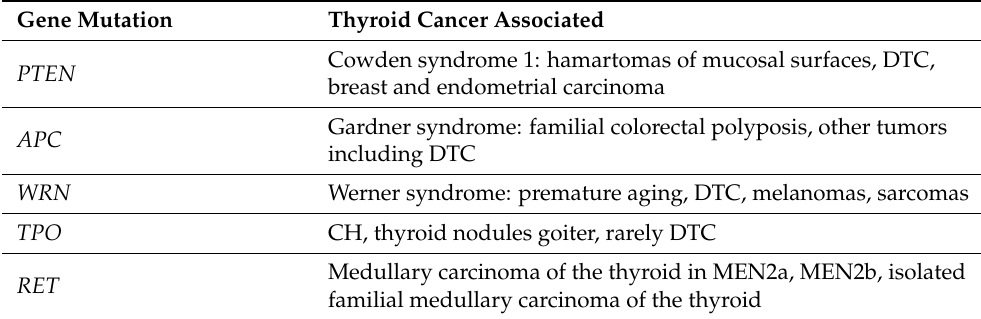
Table 3. Gene mutations and associated thyroid cancer variants (adapted from Management Guide- lines for Children with Thyroid Nodules and Differentiated Thyroid Cancer). Gene Mutation Thyroid Cancer Associated Cowden syndrome 1: hamartomas of mucosal surfaces, DTC, PTEN breast and endometrial carcinoma Gardner syndrome: familial colorectal polyposis, other tumors including